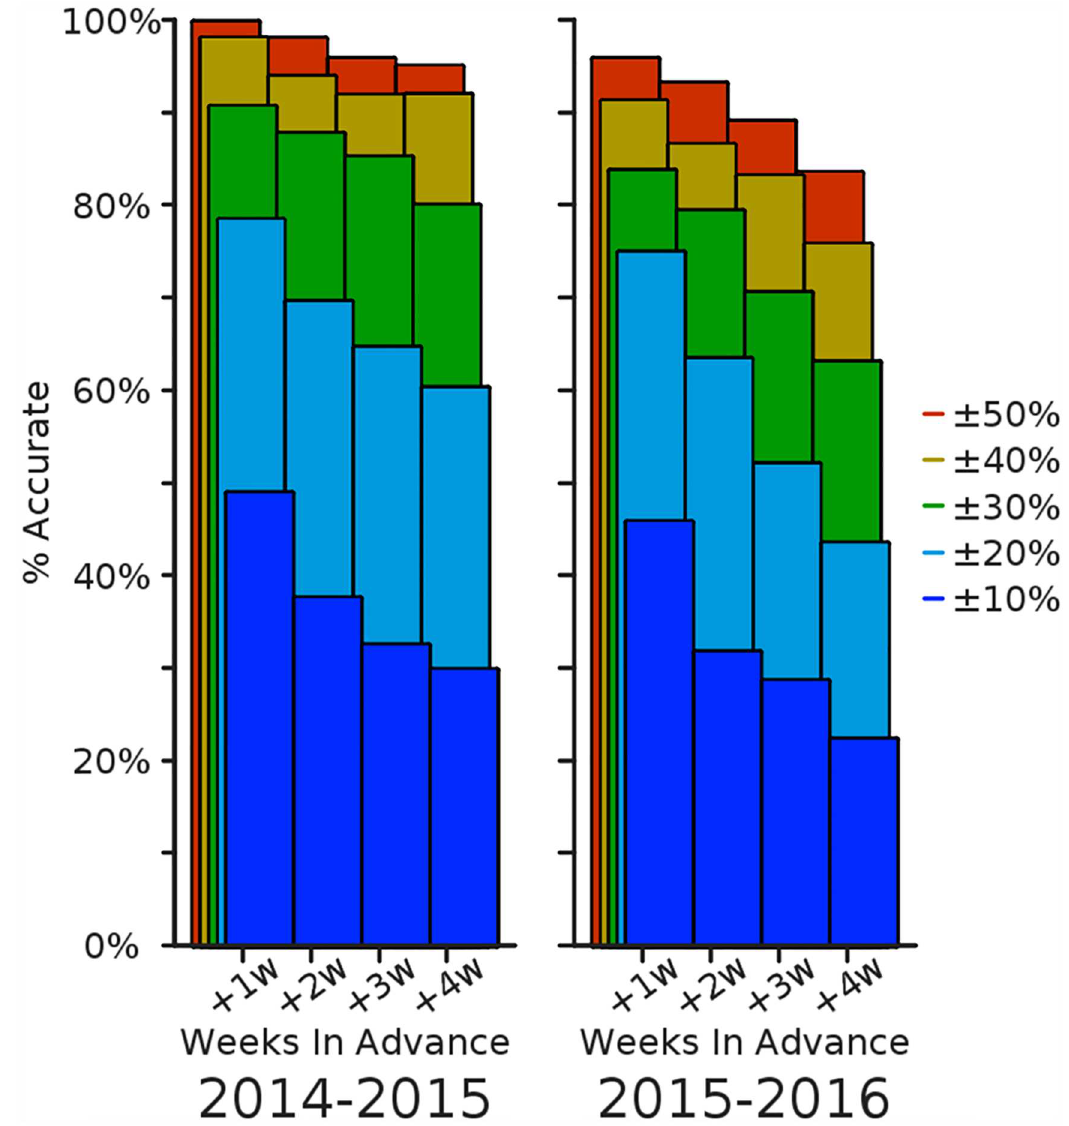
Fig 3. Relative prediction accuracyon short-term targets. The percent of regions and submission weeks ( n 2014 = 352, n 2015 = 330) where the Epicast point predictionwas accurate within some range of the actual value is shown separately for each of the four short-term targets.